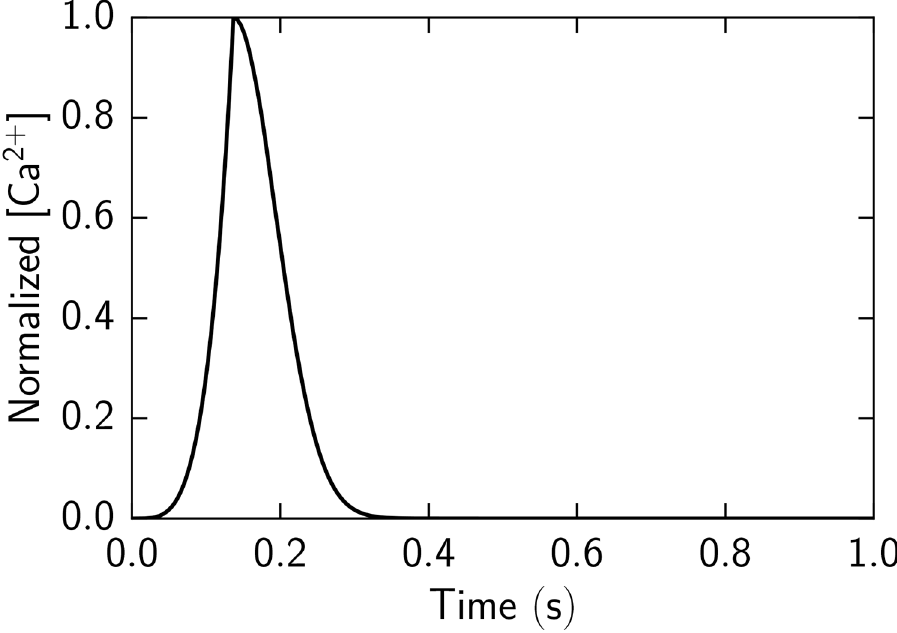
Fig 9. Normalized Ca 2+ concentration transient used in